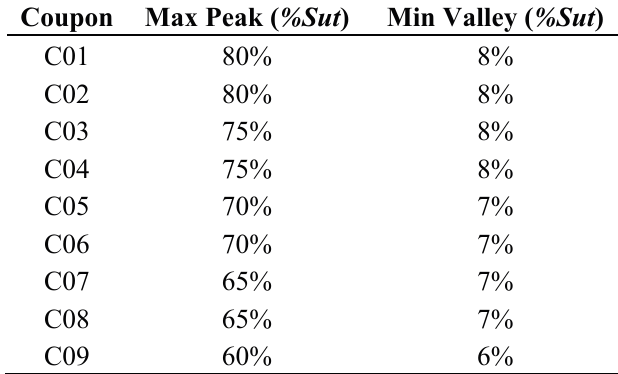
Table 1. Different magnitude of load sequences applied to the evaluated